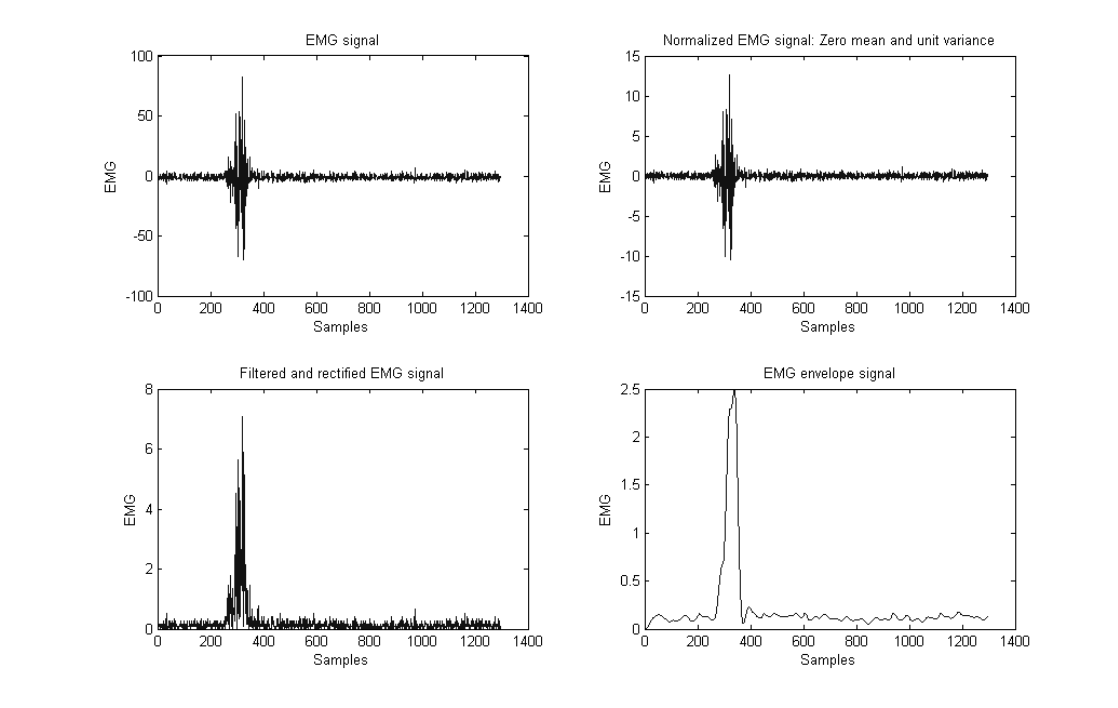
Figure 8. Filtered and rectified EMG